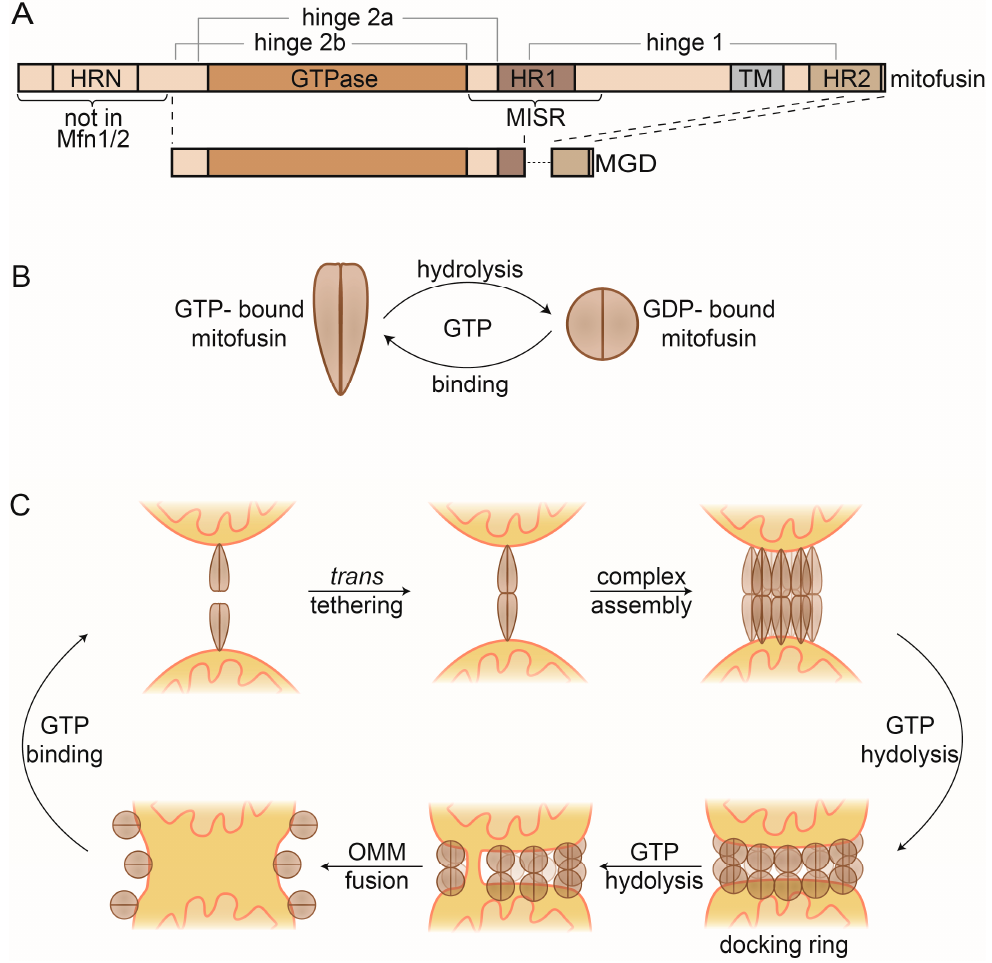
Figure 4. Mitofusins and OMM fusion. ( A ) Linear representation of the domain structure of full-length mitofusins and the minimal GTPase domain (MGD). ( B ) GTP-dependent conformational changes of mitofusin dimers. GTP-bound mitofusin is in a stretched conformation, which constricts upon GTP hydrolysis. ( C ) Current model of OMM fusion. GTP-bound Fzo1 dimers on the OMM facilitate mitochondrial tethering via trans oligomerization. After higher complex formation, GTP